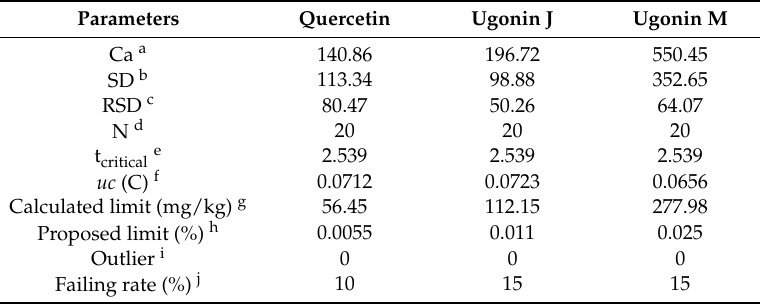
Table 5. Mean contents and proposed content limits for three analytes in HZ. Parameters